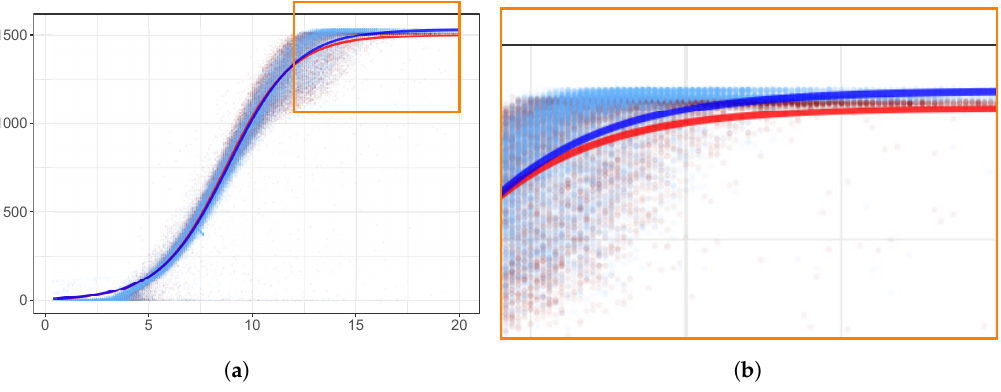
Figure 1. Scatter-plot of the wind speed versus power of the generator before and after failure for turbine 153. Logistic functions (sigmoids) that best fit the data points before (red) and after (blue) the maintenance intervention are superimposed. Panel ( a ) shows the entire power curve, while panel ( b ) shows the critical part where maximum power is expected.